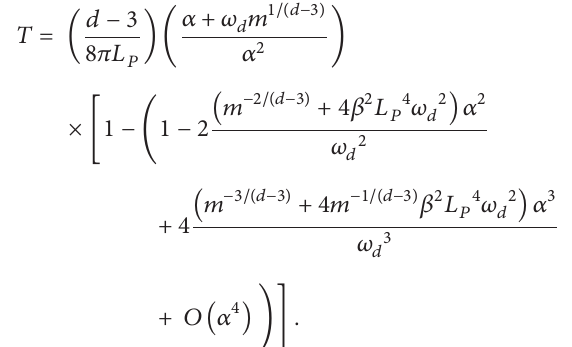
Figure 6: Temperature of a black hole as a function of mass with GUP ∗∗ and for different numbers of space-time dimensions with 𝛼 = 1 and 𝛽 = 0.01 . Mass is in the unit of the Planck mass and temperature is in the unit of the Planck